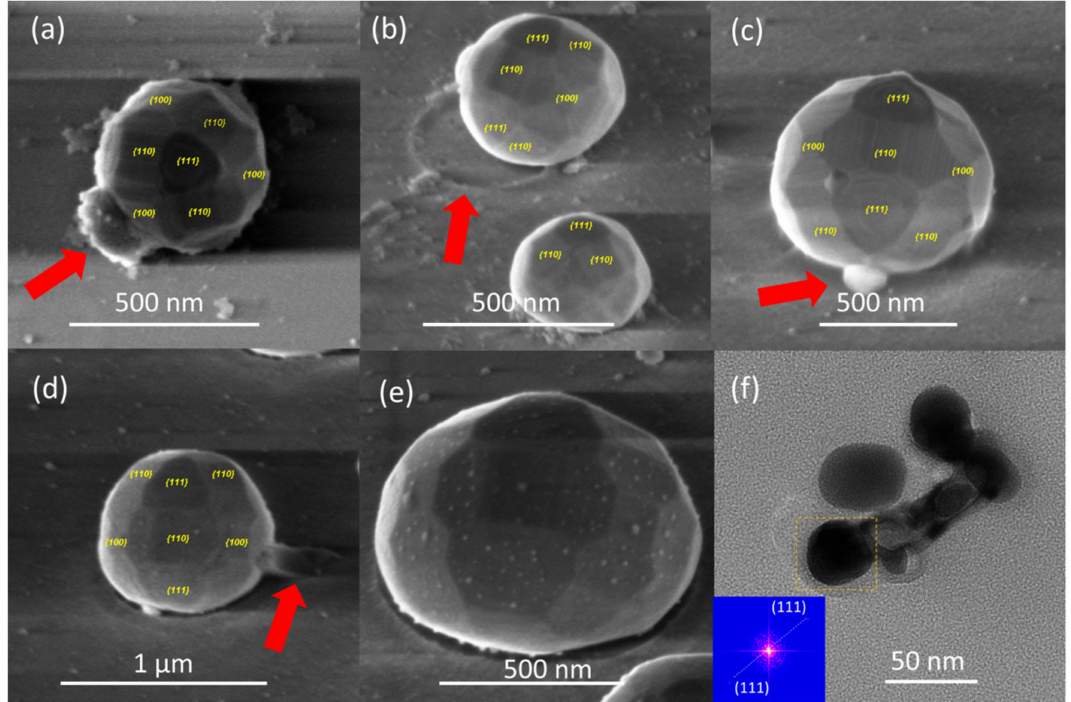
Figure 13. ( a – e ) Representative FE-SEM micrograph images of different Ag nanoparticles obtained by the solid-state thermal dewetting process. ( a ) top- and ( b – e ) tilted-view images to show the different low-index facets to highlight various features. ( f ) Representative HR-TEM micrograph image of silver nanoparticles obtained by the SSD process. Inset of ( f ) shows the FFT pattern extracted from the HR-TEM micrograph of the Ag NP enclosed by a yellow dashed rectangle in panel ( f ). Samples depicted in ( a – c , f ) have been obtained by applying the constant temperature region program depicted in Figure 1 with the following SSD process parameters: ( a ) d Ag = 40 nm, T A = 450 ◦ C, t A = 51 min; ( b ) d Ag = 40 nm, T A = 450 ◦ C, t A = 17 min; ( c ) d Ag = 80 nm, T A = 500 ◦ C, t A = 60 min; and ( f ) d Ag = 80 nm, T A = 500 ◦ C, t A = 17 min. The samples shown in ( d , e ) were obtained